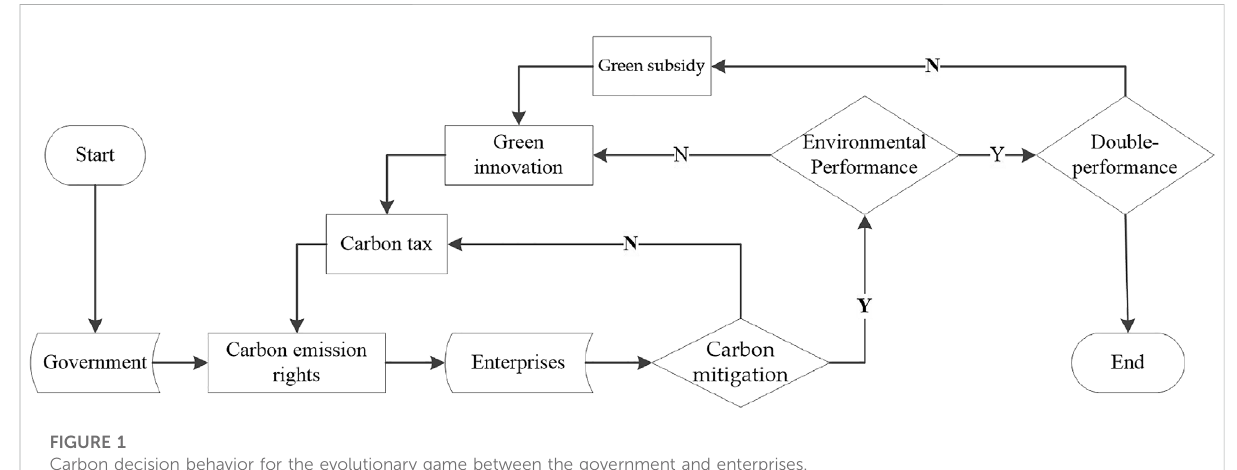
FIGURE 1 Carbon decision behavior for the evolutionary game between the government and enterprises.